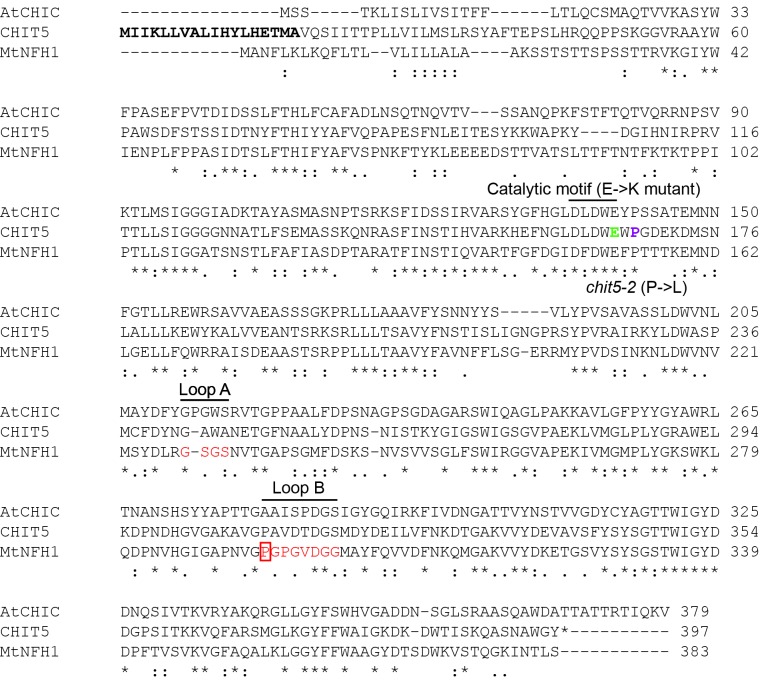
Amino acid alignment of CHIT5, AtCHIC, MtNFH1.Amino acid sequence alignment of Lotus japonicus CHIT5, Medicago truncatula NFH1 (KC833515) and Arabidopsis thaliana CHIC (NP_193716). (*) indicates a conserved residue, (:) indicates strongly similar properties, (.) indicates weakly similar properties, (-) indicates gaps. A predicted signal peptide is indicated in bold for CHIT5. The conserved catalytic motif DxDxE is indicated as is the position of the E-K mutation (green) introduced to produce an inactive CHIT5 construct. The position of the P-L substitution in chit5-2 is indicated (magenta). The position of A and B loops (in red) and of the proline residue (red box) identified as important for Nod factor hydrolase activity of MtNFH1 are indicated.